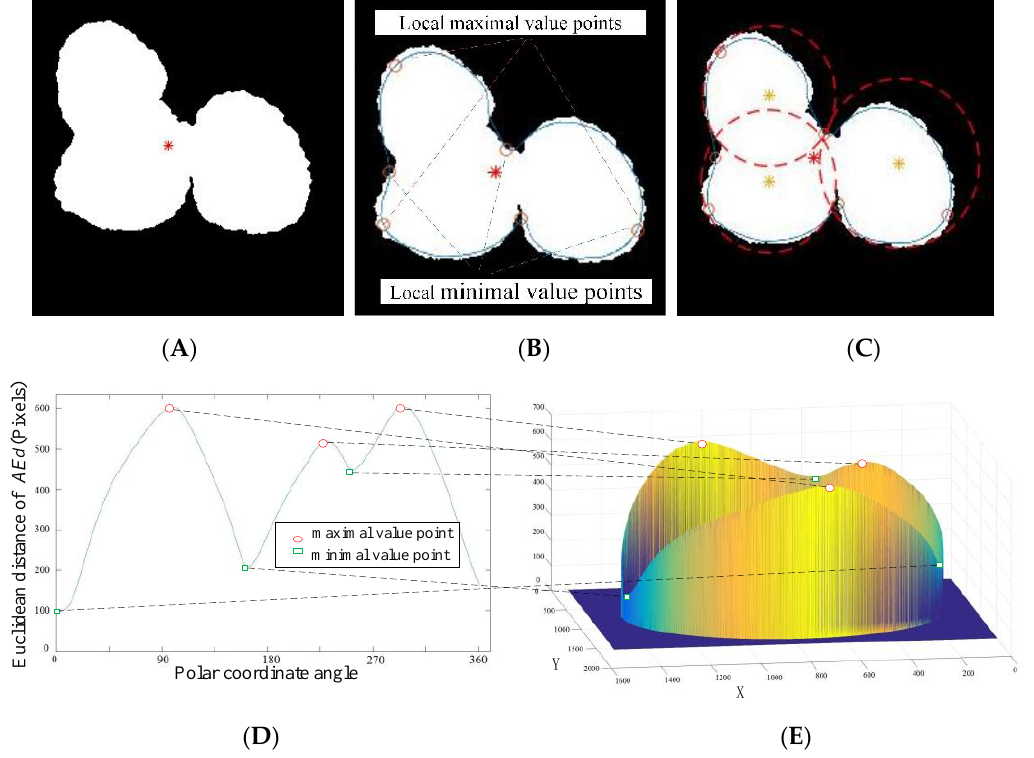
Figure 8. Example of image processing using polar coordinate extreme value projection (PCEVP) processing. ( A ) Determine the center of gravity of the foreground region ( B ) by calculating all local maximal and minimal value points on the boundary of the foreground region. ( C ) Individual foreground regions in ( B ) segmented using PCEVP. ( D ) The Euclidean distance |𝐴𝐸 𝑑 | and extreme value points of the foreground region boundary. ( E ) The Euclidean distance |𝐴𝐸 𝑑 | in bar graph in a 3D coordinate system.